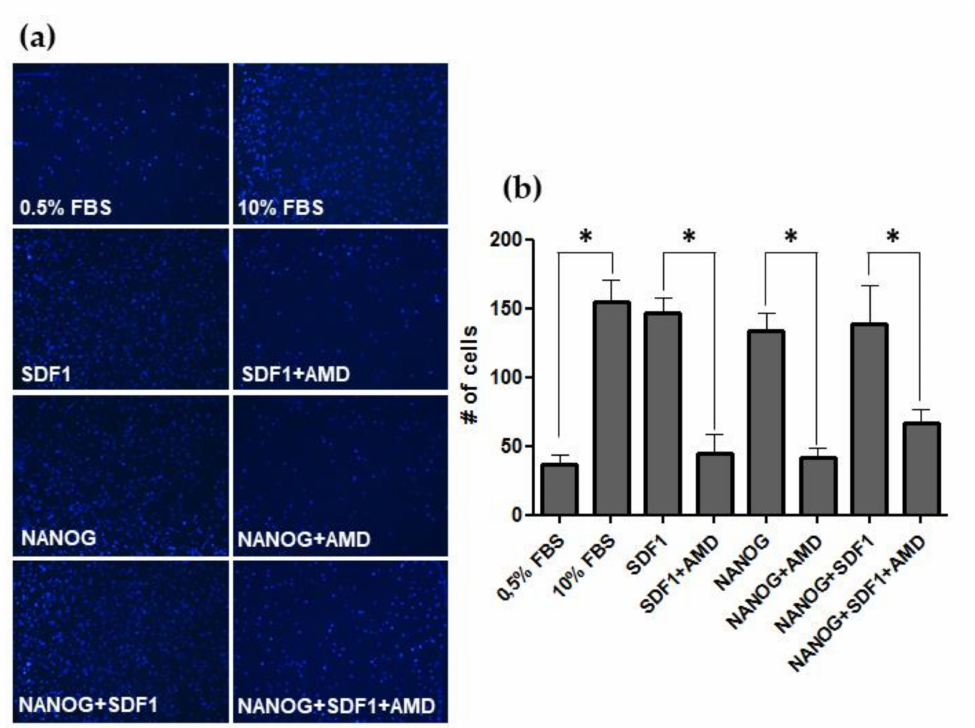
Figure 4. h-NANOG regulates human tumor cell migration through CXCR4. ( a ) Transwell membranes showing migrated cell nuclei stained with DAPI. ( b ) Bar graphs showing the number of cell that migrates in response of different conditions. Cells migrated in higher proportion attracted by a greater concentration of serum (10%, positive control), by the presence of SDF1, NANOG or both. The increased migration due to SDF1 or NANOG was inhibited by the presence of AMD3100 (AMD), a specific inhibitor of CXCR4 receptor. * corresponds to p <